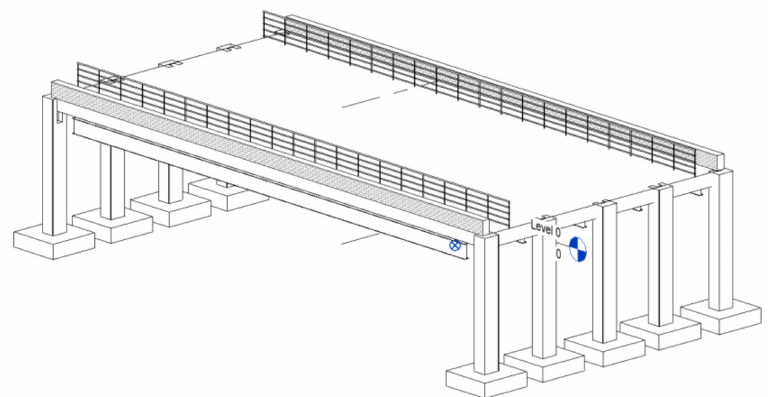
Figure 4. Revit BIM model for sample bridge.